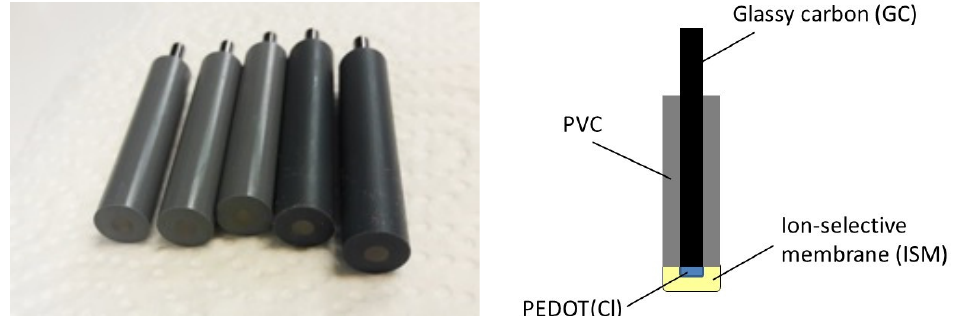
Figure 2. The disc electrodes based on the glassy-carbon (GC) material used for the preparation of the ISE ( left ). Scheme of the solid-contact ion-selective electrode (SC-ISE) employed in this paper ( right